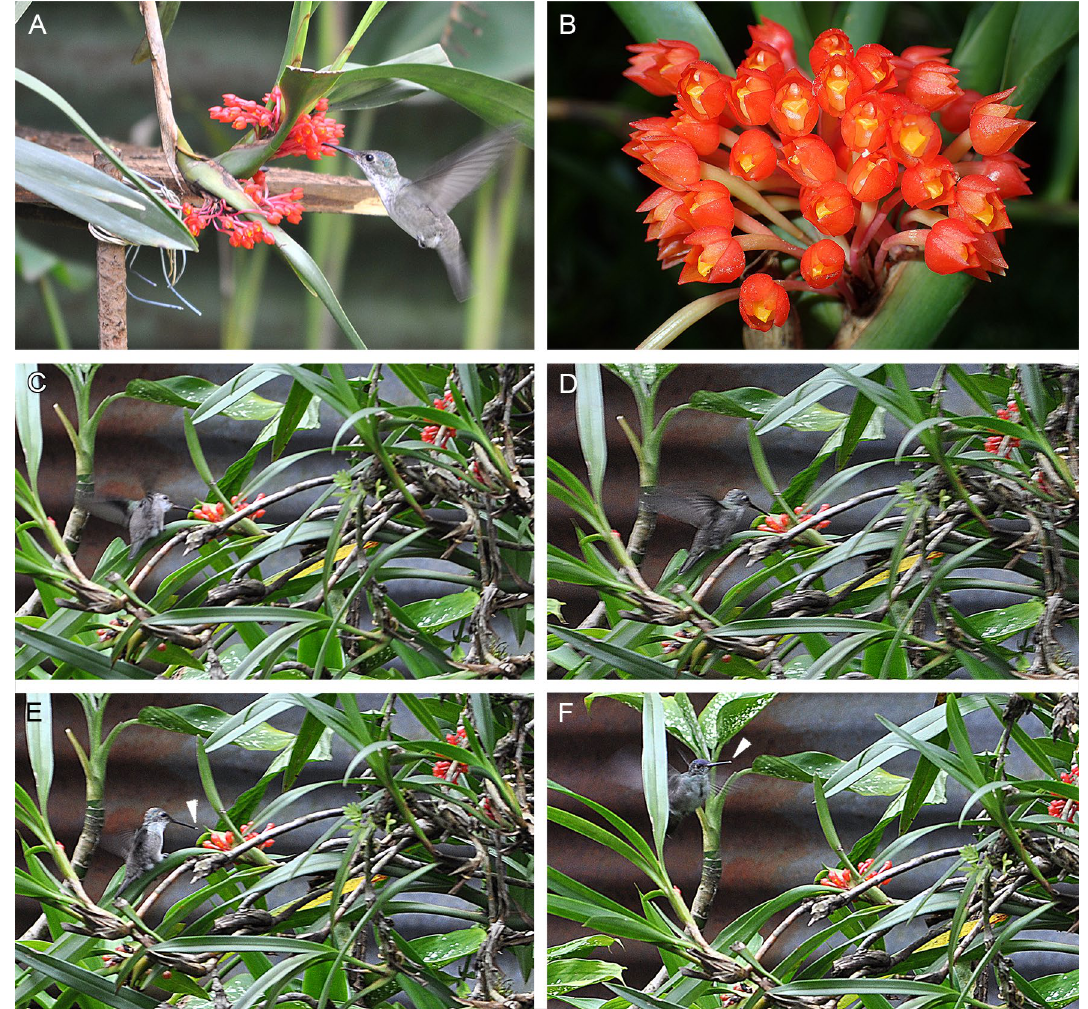
Figure 1. Observations in Estación Experimental de Orquídeas de la Familia Archila (Cobán, Guatemala) in 2017–2020: ( A ) The azure-crowned hummingbirds ( Amazilia cyanocephala ) regularly visiting the flowers of Ornithidium fulgens ; ( B ) Inflorescence: flowers with predominating red colour and contrasting yellow lip; ( C – F ) Sequence of photos showing the moments of the hummingbird’s visit, which results in the collection of pollinia; ( E , F ): pollinia attached to the beak ( arrows ). Phot. A, C-F: F. Archila; B: M.